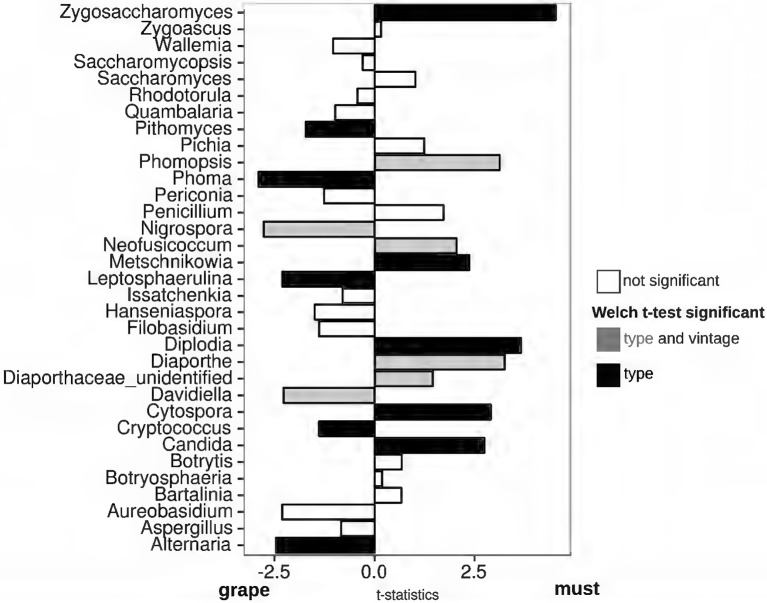
Welch's t-statistics comparing the relative abundances of fungal genera present in grapes and must samples. Welch's t-test was carried out to compare the relative abundances of fungal genera in grape and must samples. Black = FDR < 0.05 among sample matrices and FDR > 0.05 among vintages, Gray = FDR < 0.05 among matrices and FDR < 0.05 among vintages, white = FDR > 0.05.